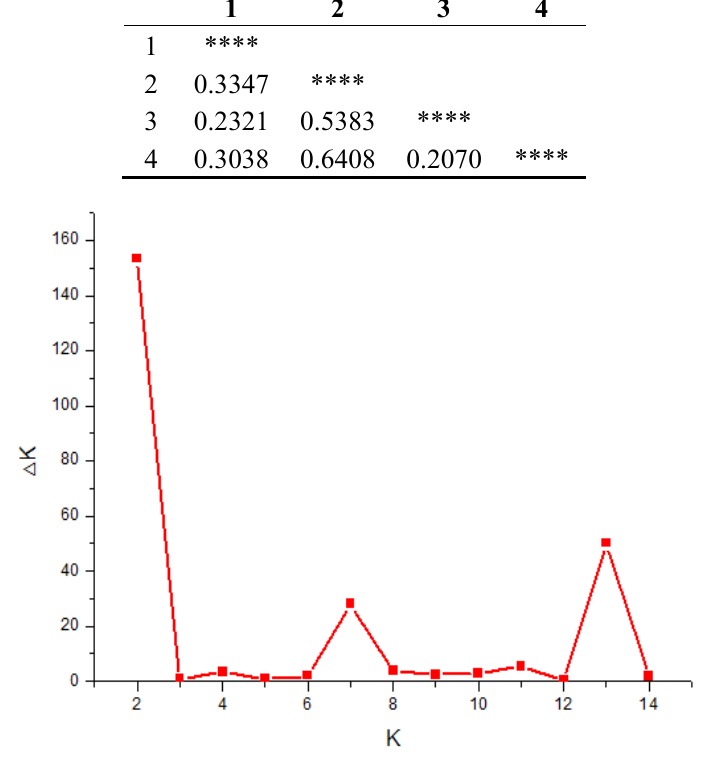
Figure 3. Relations between K and ∆ K